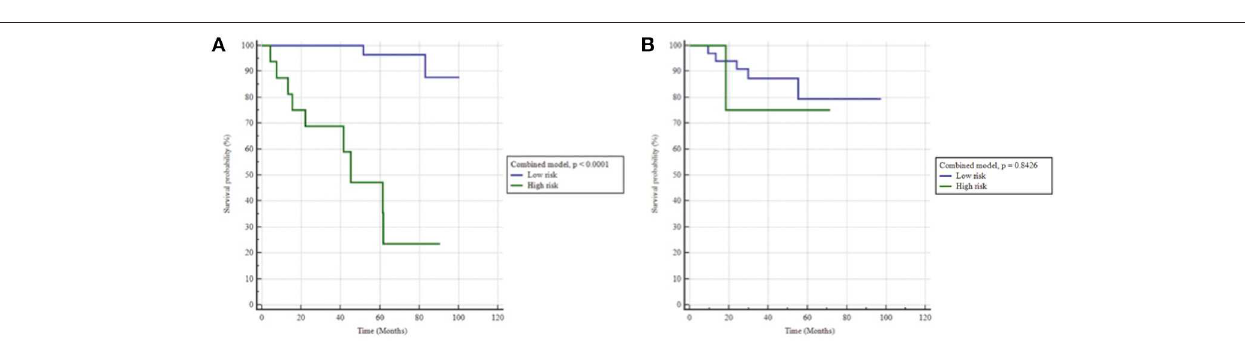
for more robust predictive markers of BCR to adapt the